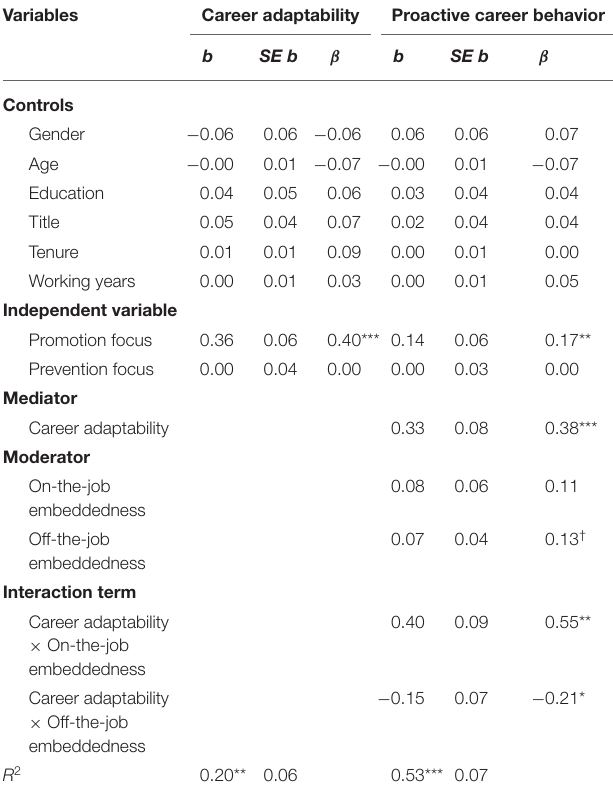
N = 247. The moderation and moderated mediation hypotheses were tested simultaneously. All continuous predictors were mean-centered (Edwards and Lambert, 2007). Model fit statistics: χ 2 (127) = 236.84, CFI = 0.93, TLI = 0.91, RMSEA = 0.06, SRMR = 0.04. b, unstandardized coefficient; SE, standard error; β , standardized